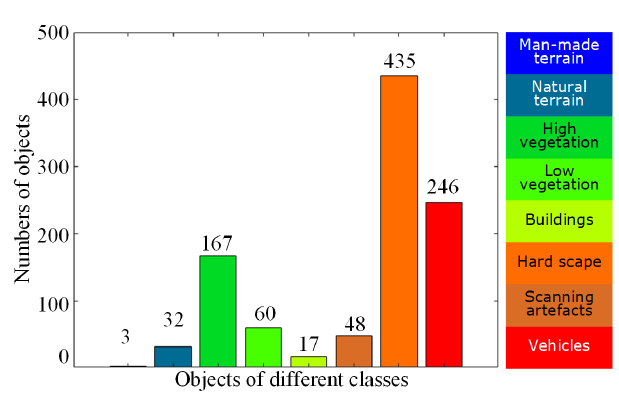
Figure 8. Numbers of objects from different classes in the dataset for instance segmentation.